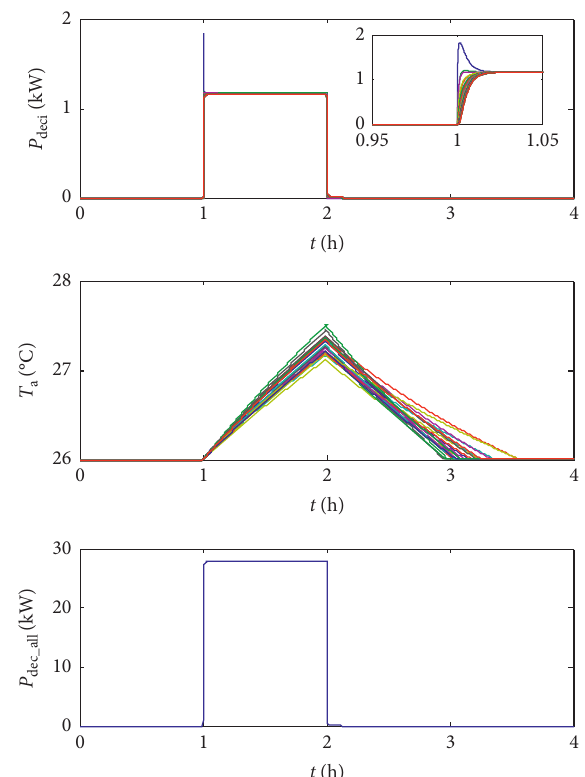
Figure 9: Simulation results of method 2.